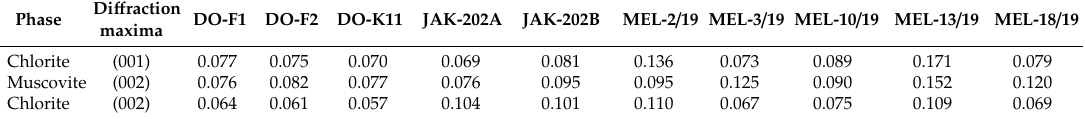
Table 13. Meliata Unit flysch metasediments. Full width at half maximum of selected Chl and Ms diffraction maxima at Δ °2 θ CuK α .